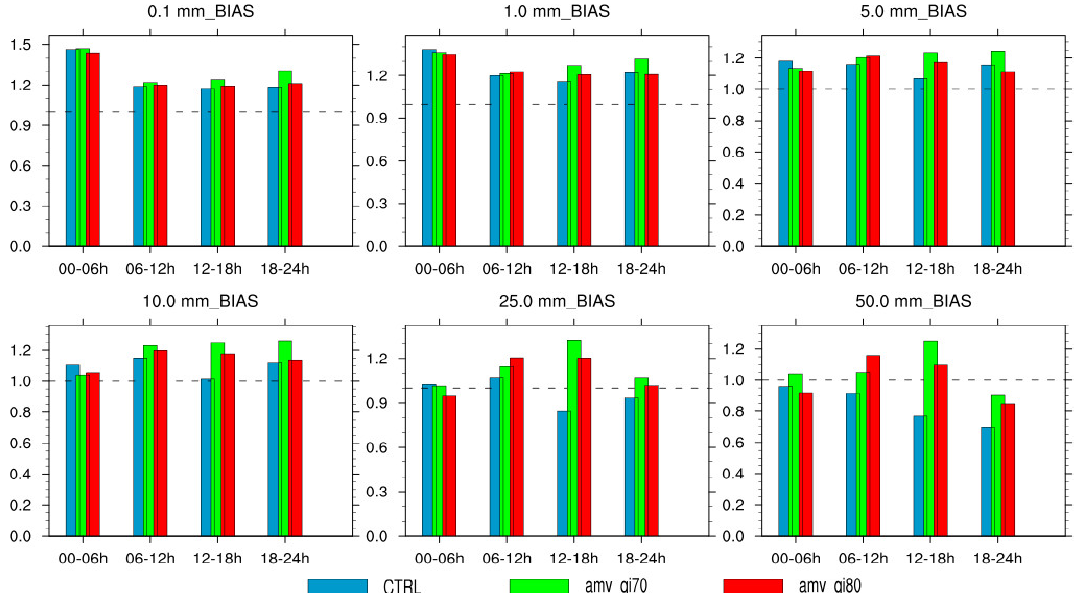
Figure 9. The CSI score of 6 h accumulated precipitation over the 3 km domain from the three ex- periments of the CTRL, amv_qi70 and amv_qi80 for the thresholds of 0.1 mm, 1.0 mm, 5.0 mm, 10.0 mm, 25.0 mm and 50.0 mm.